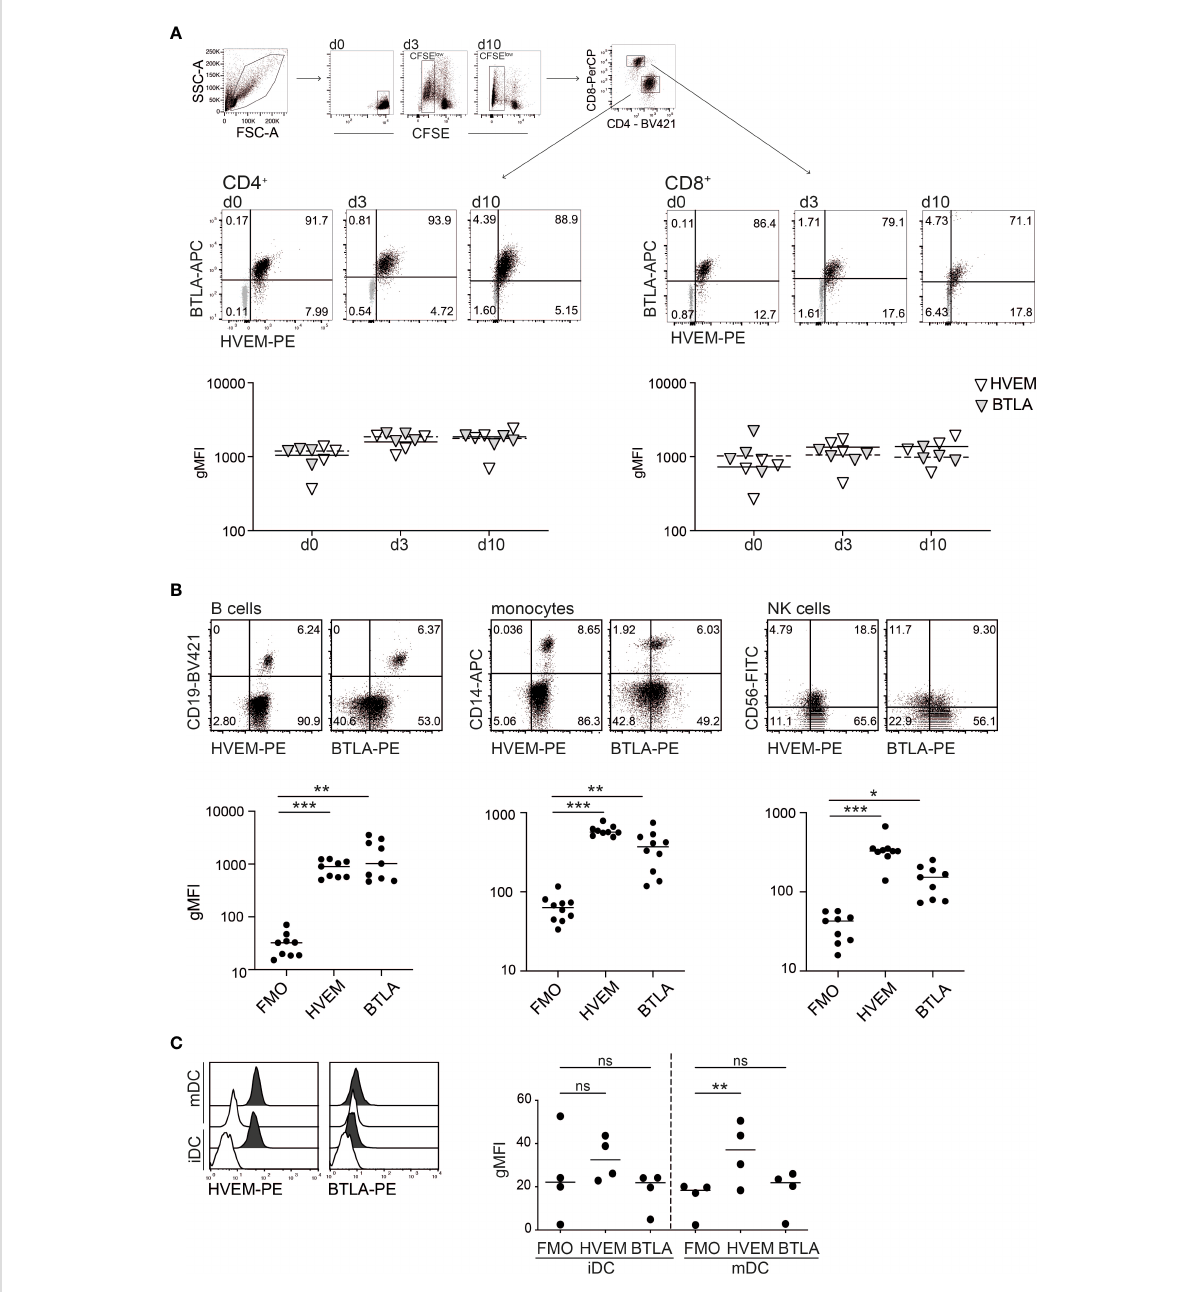
FIGURE 1 Expression analysis of HVEM and BTLA. (A) Gating strategy used to analyse HVEM and BTLA expression on resting (d0) and SEE-stimulated (d3, d10) CFSE-labelled PBMCs derived from healthy donors. Expression was analysed in gated CD4 + and CD8 + T cells at the indicated time points. Upper panel: data of one representative donor is shown. Isotype controls are shown in grey. Lower panel: summarized data of geometric mean fl uorescence intensity (gMFI) of HVEM and BTLA expression in CD4 + and CD8 + T cells (gated on CFSE low cells on d3 and d10) (n=4, 3 experiments with 1-2 donors). (B) B cells (CD19 + ), monocytes (CD14 + ) and NK cells (CD56 + ) were analysed for HVEM and BTLA expression. Upper panel: blots depict data from one representative donor. Lower panel: summarized data (gMFI is shown; n=9, 4 experiments with 2-3 donors). (C) HVEM and BTLA expression was analysed on immature (iDC) and mature dendritic cells (mDC) ( fi lled histogram: speci fi c expression of indicated molecule, open histogram: FMO control), (n=4, 3 experiments with 1-2 donors). (A-C) Each symbol represents one donor. Lines indicate median gMFI. For statistical evaluation one-way ANOVA followed by Bonferroni correction was performed (***p ≤ 0.001; **p ≤ 0.01; *p ≤ 0.05; ns, p >